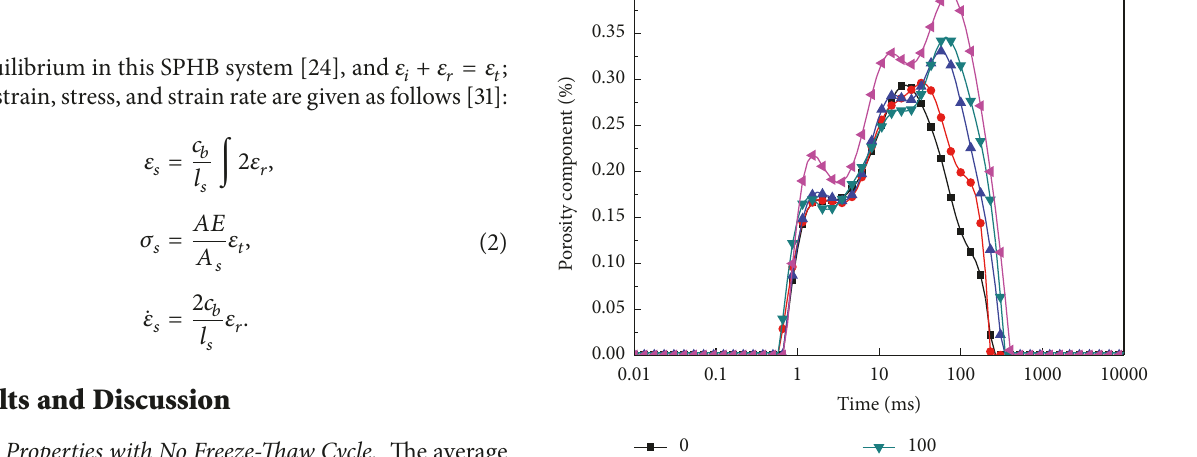
Figure 3: Dynamic force equilibrium for a typical dynamic com- pressive test.